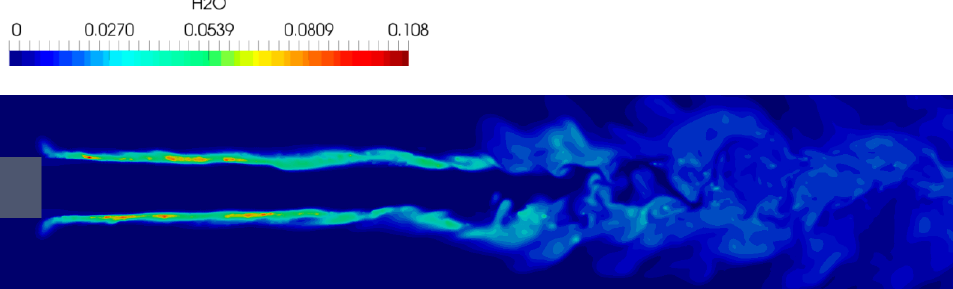
Figure 8. Instantaneous mass fraction of water (as mentioned in Equation (4)).